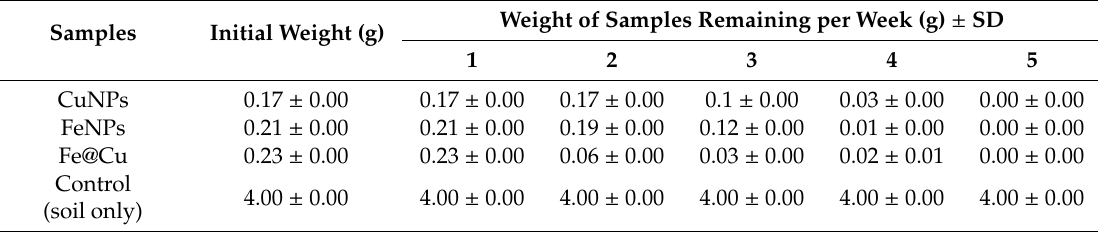
Table 5. Biodegradation study on nanoparticles (CuNPs, FeNPs and Fe@Cu) at room